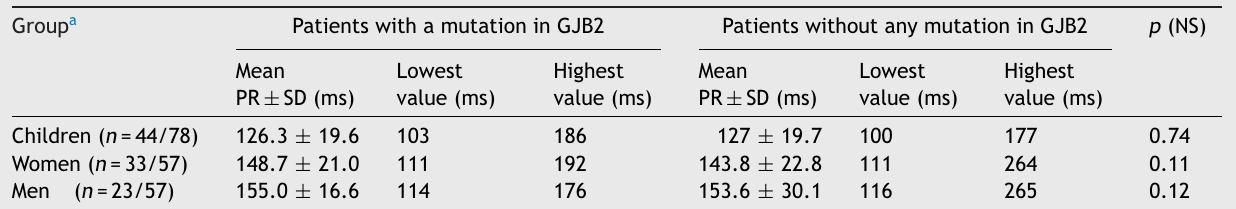
a Numbers in brackets indicate the number of patients with/without GJB2